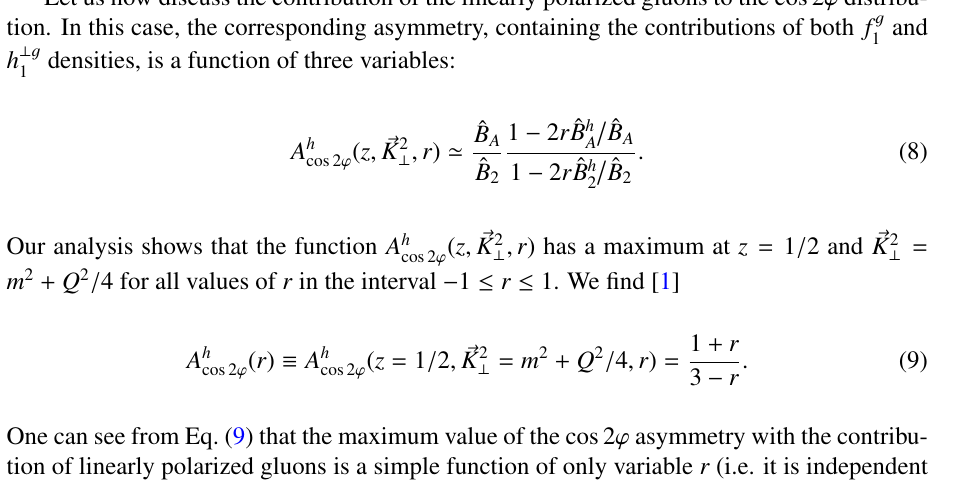
= m 2 + Q 2 / 4) in heavy- ⊥ (cid:14) Q 2 . Right panel: maximum value ( r ), as a function of cos2 ϕ